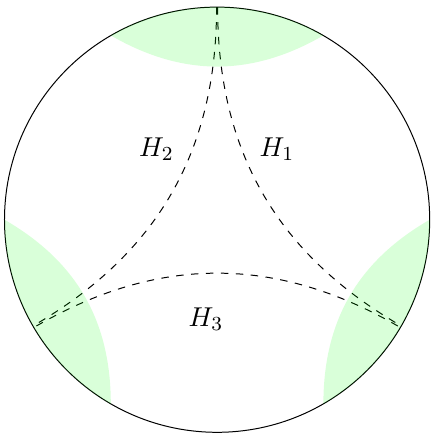
Figure 7. A schematic diagram of the t = 0 slice of a three-boundary black hole in the hot limit. For any pair of horizons (dashed lines), there is a large region which we call D green) where the horizons are exponentially close to each other. The causal shadow is the region bounded by the three